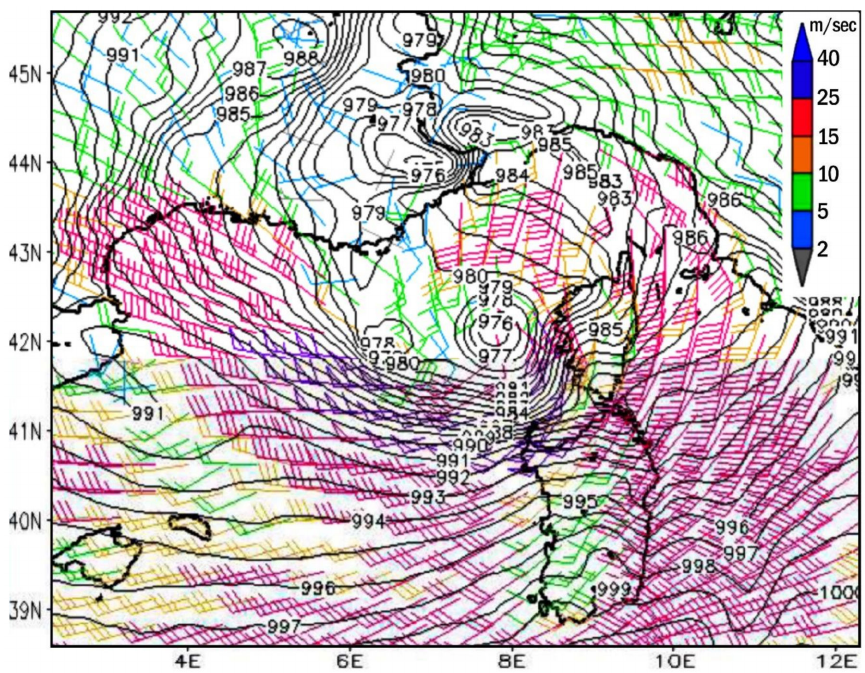
Figure 4. Wind at 10 m (m/s) and mean sea-level pressure (hPa) during Vaia Storm on 29 October 2018, 00 UTC (modified after ARPAL (Regional Agency for Ligurian Environment Protection)